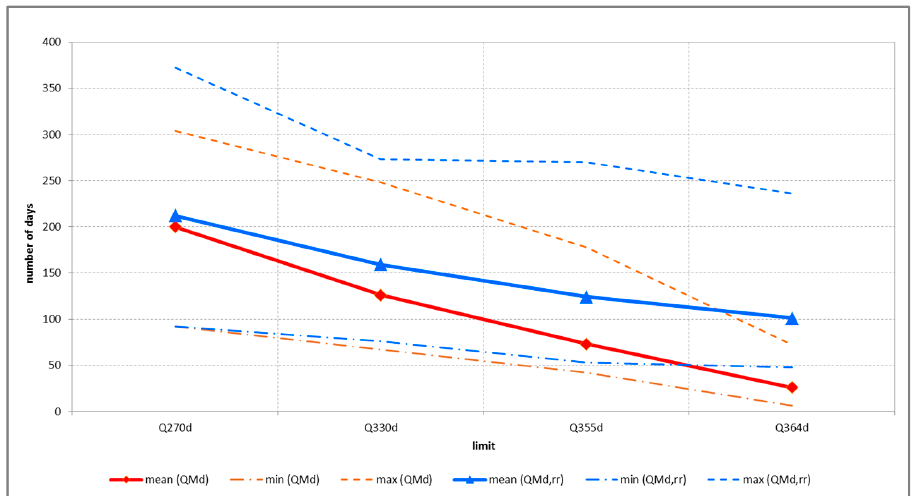
Figure 8. The longest drought event duration (mean and extremes of individual WSs), 1961–2015.